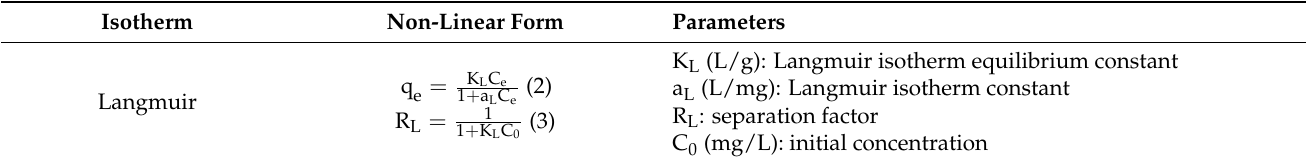
Table 2. List of seven adsorption isotherm models used in this study [30–36,41–50]. The non-linear equation of each model expresses the amount of pollutant adsorbed at equilibrium ( q e in mg/g) in function of liquid phase pollutant concentration at equilibrium ( C e in mg/L). Isotherm Non-Linear Form